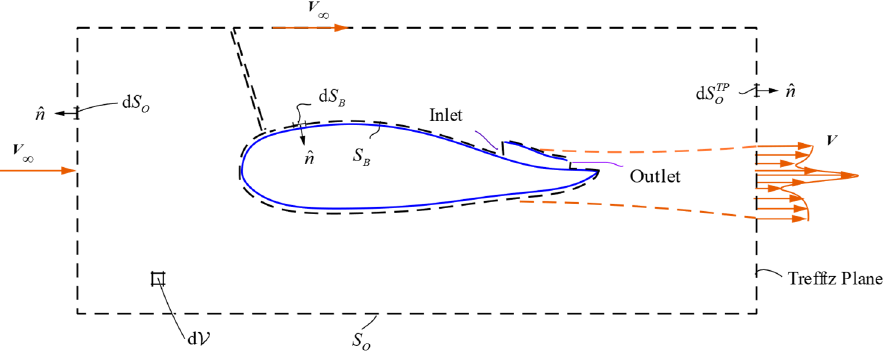
Figure 2. Two ‐ dimensional (2D) cross ‐ section of the control volume v for power balance analysis. Figure 2. Two-dimensional (2D) cross-section of the control volume v for power balance